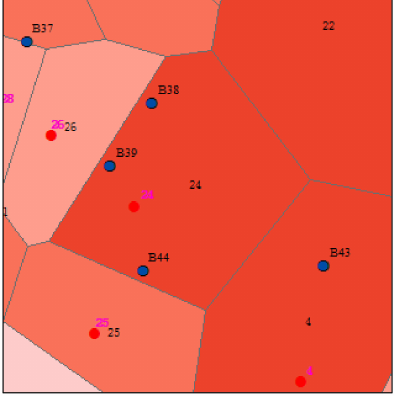
Figure 7. Substations in the service area with the lowest water